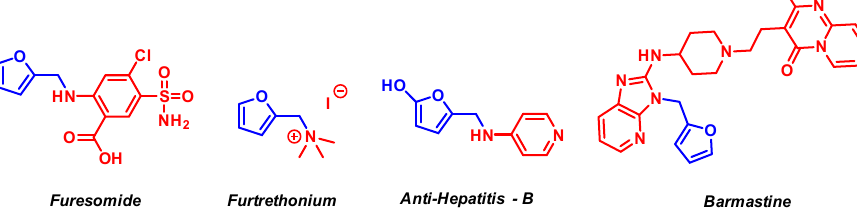
Figure 1. Pharmaceutical compounds containing furfurylamines.